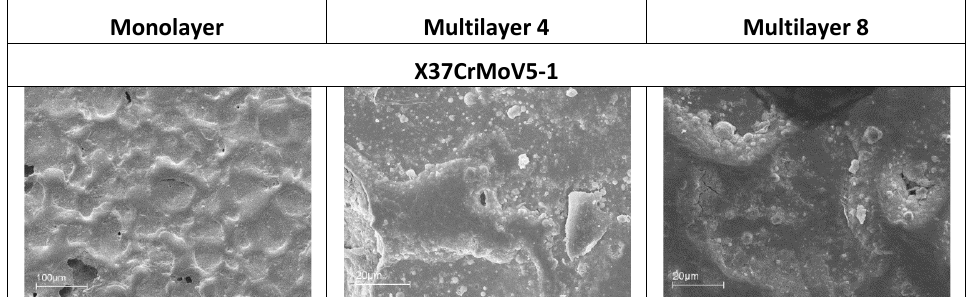
Figure 22. SEM images of X37CrMoV5-1 and X2NiCoMo18-8-5 electro-eroded surfaces after